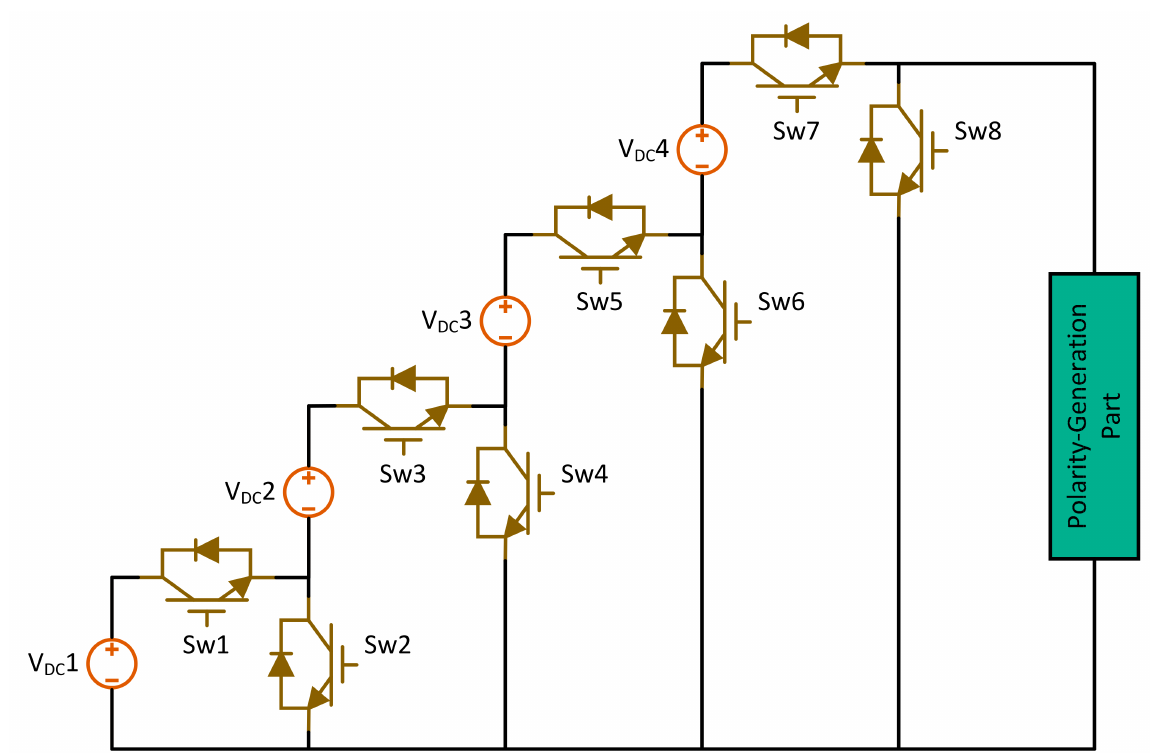
Figure 17. Topology of series connected switched sources multilevel